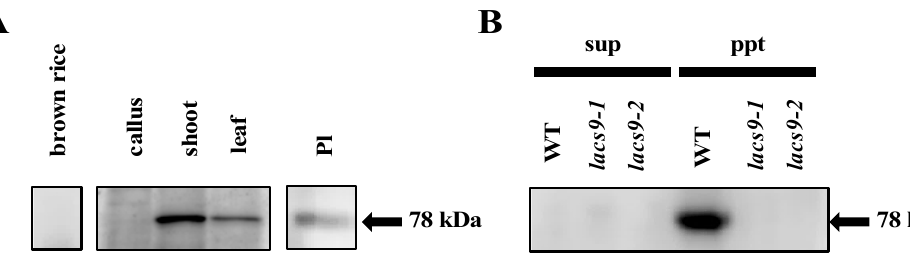
Figure 4. Long-chain acyl-CoA synthetase 9 (OsLACS9) localized to chloroplasts and membrane fraction. Immunoblot detection of OsLACS9. ( A ) Proteins (20 µ g) extracted from brown rice, callus, shoot, leaf, and intact plastid (Pl) isolated from shoots of WT line. ( B ) The soluble (sup) and membrane pellet (ppt) fractions of WT and lacs9 mutant lines shoot subjected to sodium dodecyl sulfate-polyacrylamide gel electrophoresis (SDS-PAGE) using anti-OsLACS9 antibodies. The position of protein size markers (in kDa) is indicated at the right (black arrow).